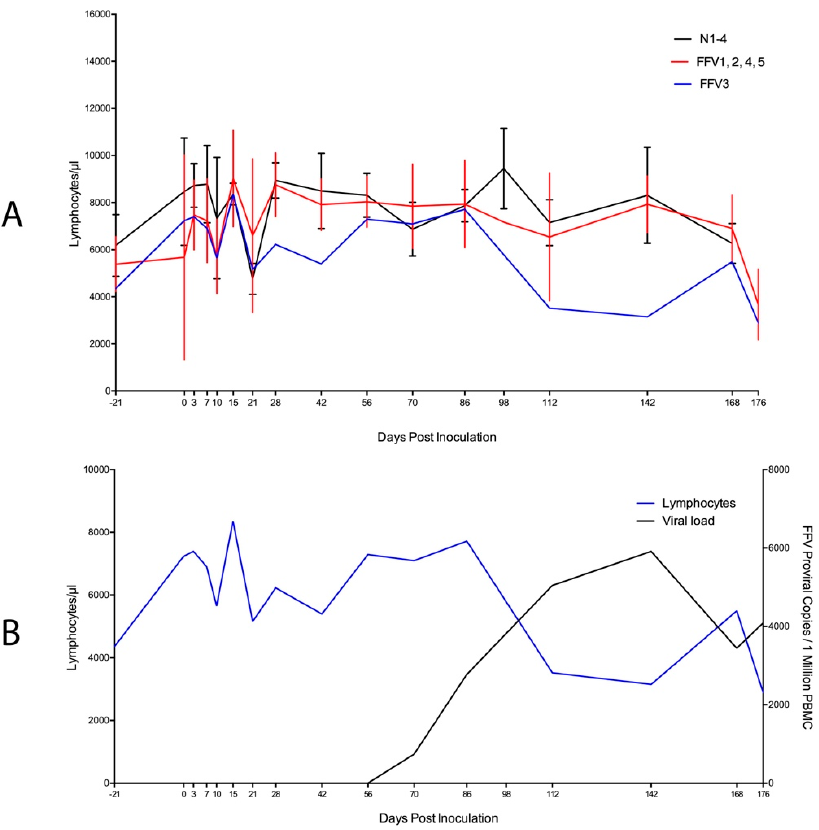
Figure 3. High viral load correlates with decline in circulating lymphocytes in cat FFV3. ( A ) Absolute lymphocyte population numbers determined through complete blood count for cat FFV3 (blue line) appeared to decrease over time compared to all other cats in the study. Naïve cats are grouped on the black line and the rest of the FFV-group cats are displayed on the red line; ( B ) A significant negative correlation ( r = − 0.653, P = 0.006) was found between lymphocytes and FFV proviral load [10] in cat FFV3 as lymphocyte population numbers (blue line) decreased and proviral load (determined by qPCR, black line) increased over time. Bars denote standard deviation.